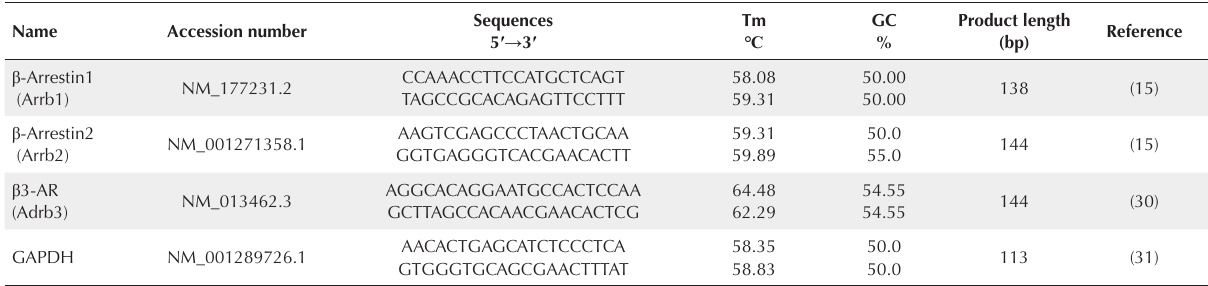
Table 1. Characteristics of the used primers